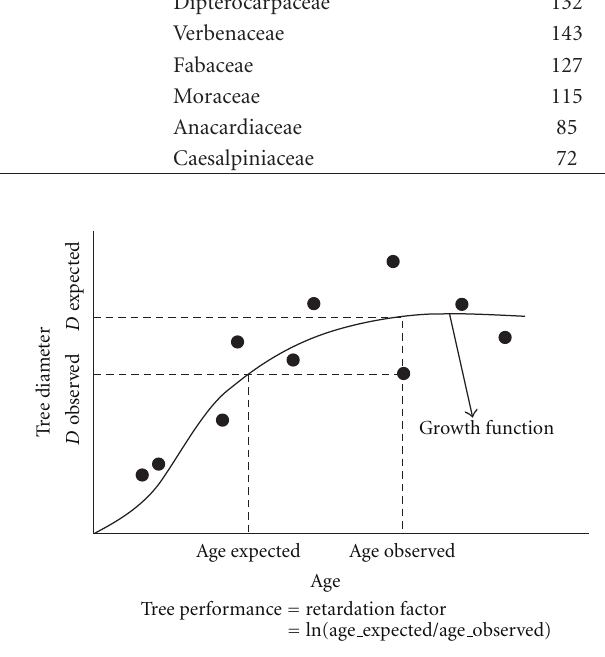
Figure 1: Representation of reference growth function and calcula- tion of Growth Retardation Factor